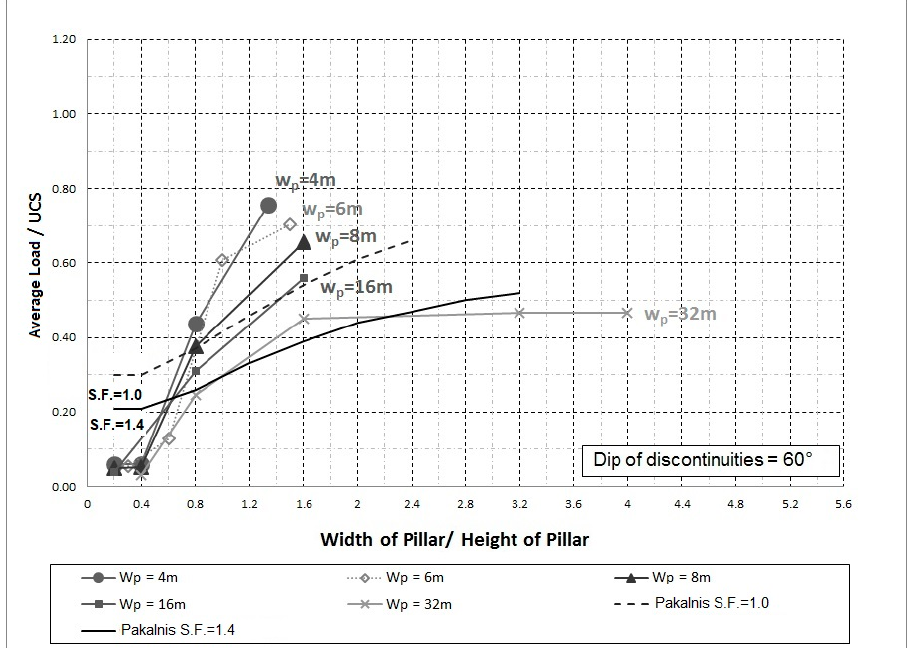
Figure 16. Failure envelopes considering the discontinuity dip angle for constant pillar width.